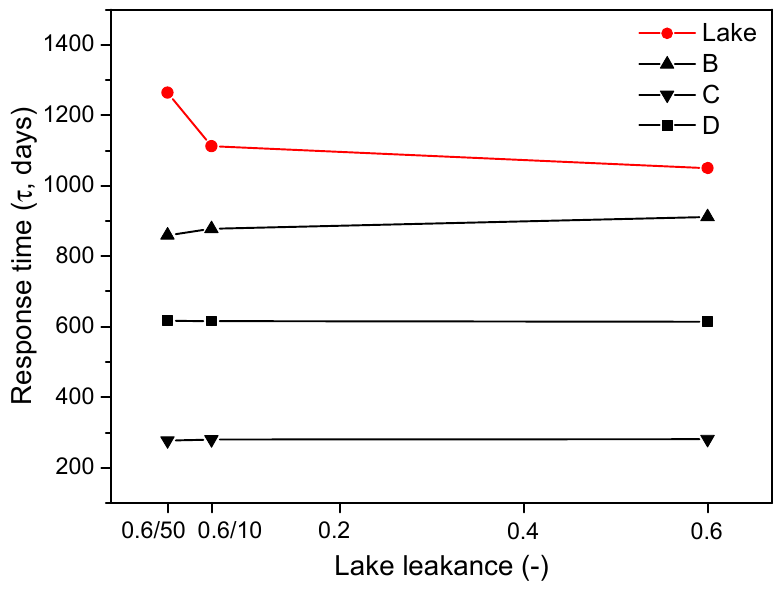
Figure 8. Relationship between lakebed leakance and the response time of lake stage, B, C and D to the climatic